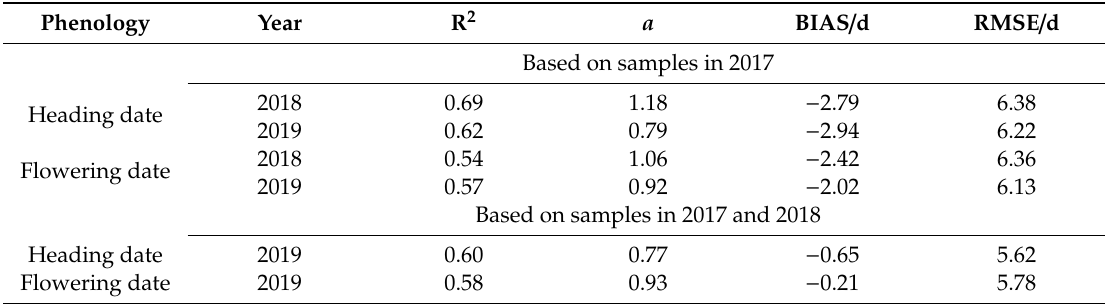
Table 2. Accuracy of the forecasted phenology by the ATM